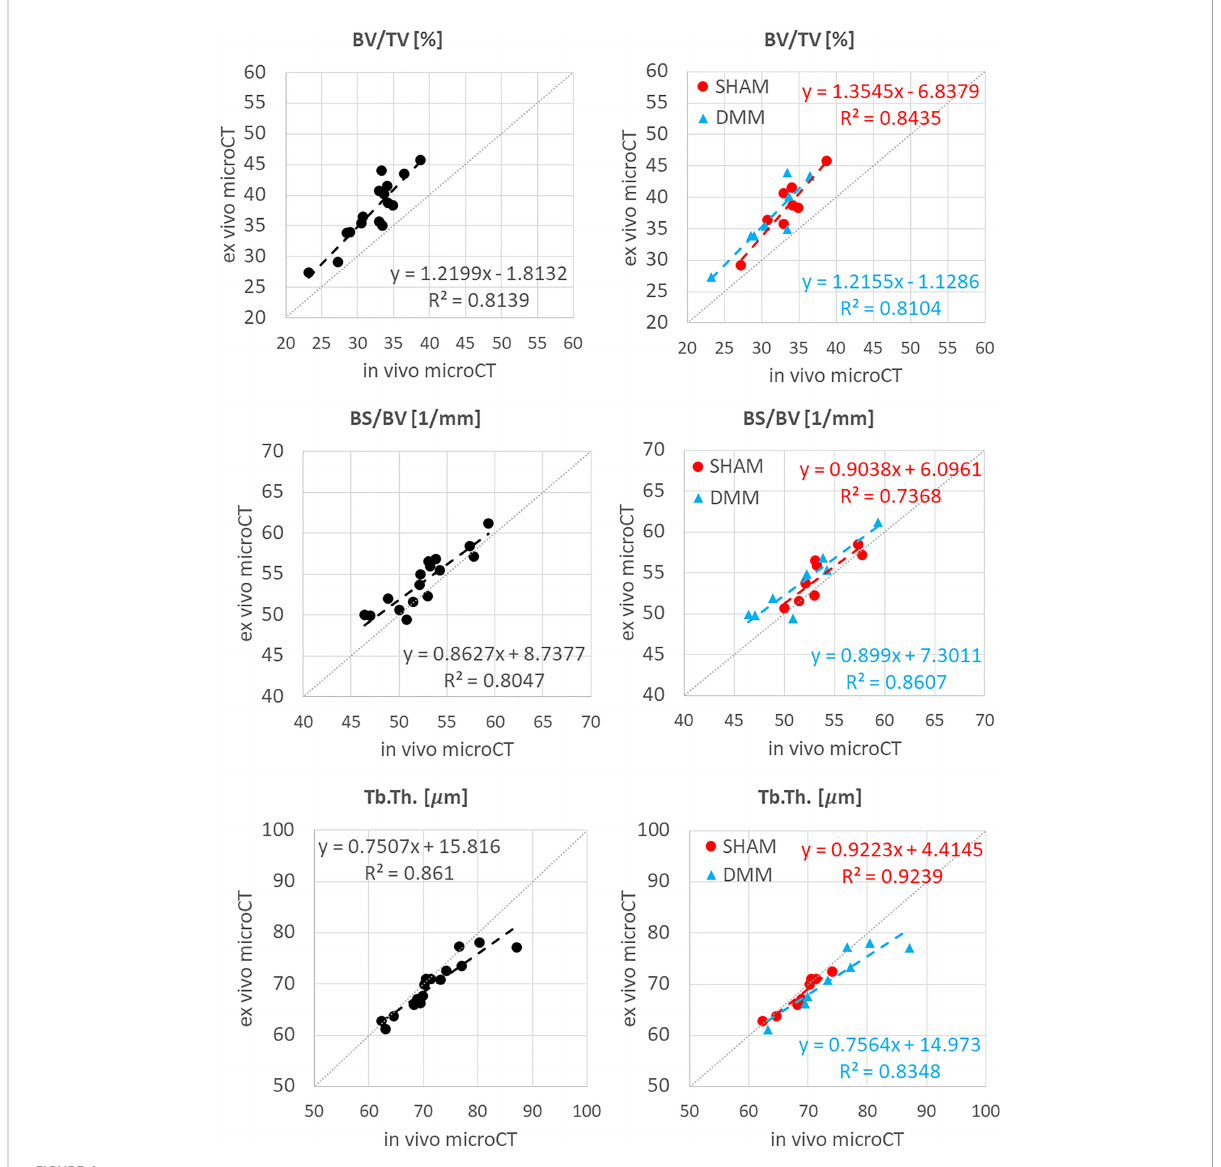
FIGURE 4 Regression analyses between in vivo and ex vivo measurements for bone volume fraction (BV/TV), bone surface fraction (BS/BV) and trabecular thickness